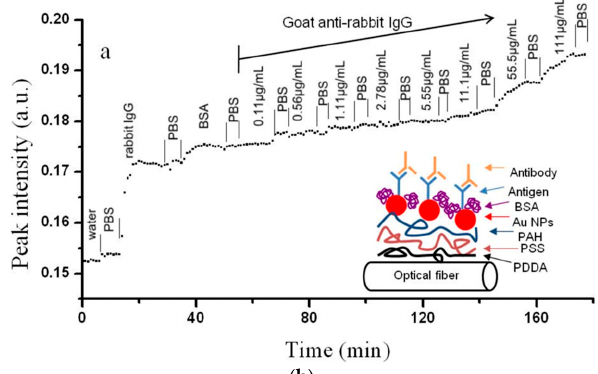
Figure 17. ( a ) Schematic representation of the experimental setup of the LSPR optical fiber sensor by using a trilayer polyelectrolyte structure which has been used to assemble the gold nanoparticles; ( b ) LSPR biosensing at different concentrations of goat anti-rabbit IgG from 0.11 to 100 μ g/mL. Reproduced from [140] with permission from Shao et al. (2010).